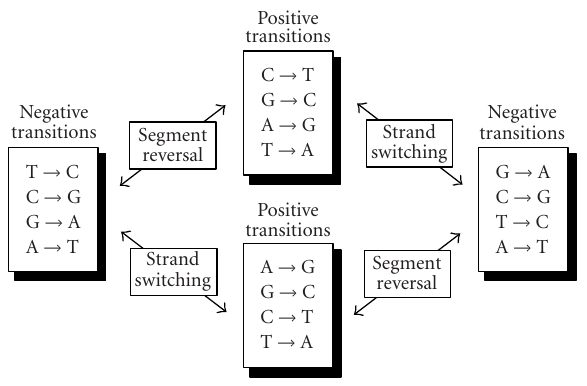
Figure 3: E ff ect of segment reversal and strand switching on pos- itive and negative nucleotide-to-nucleotide transitions. An even number of transforms do not change the type of the